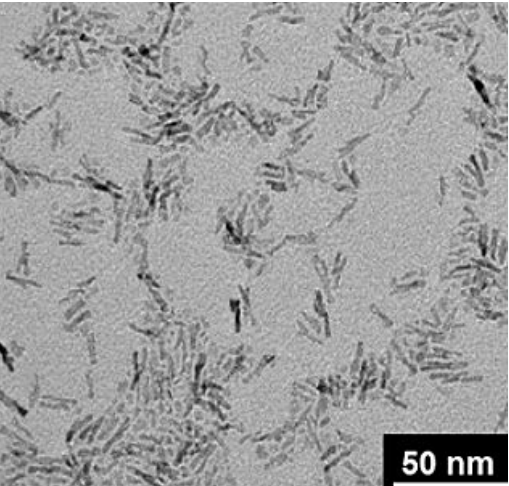
Figure 12. Transmission electron microscopy image of a typical nanocrystal sample loaded with titanium dioxide. Adapted from the reference [268].